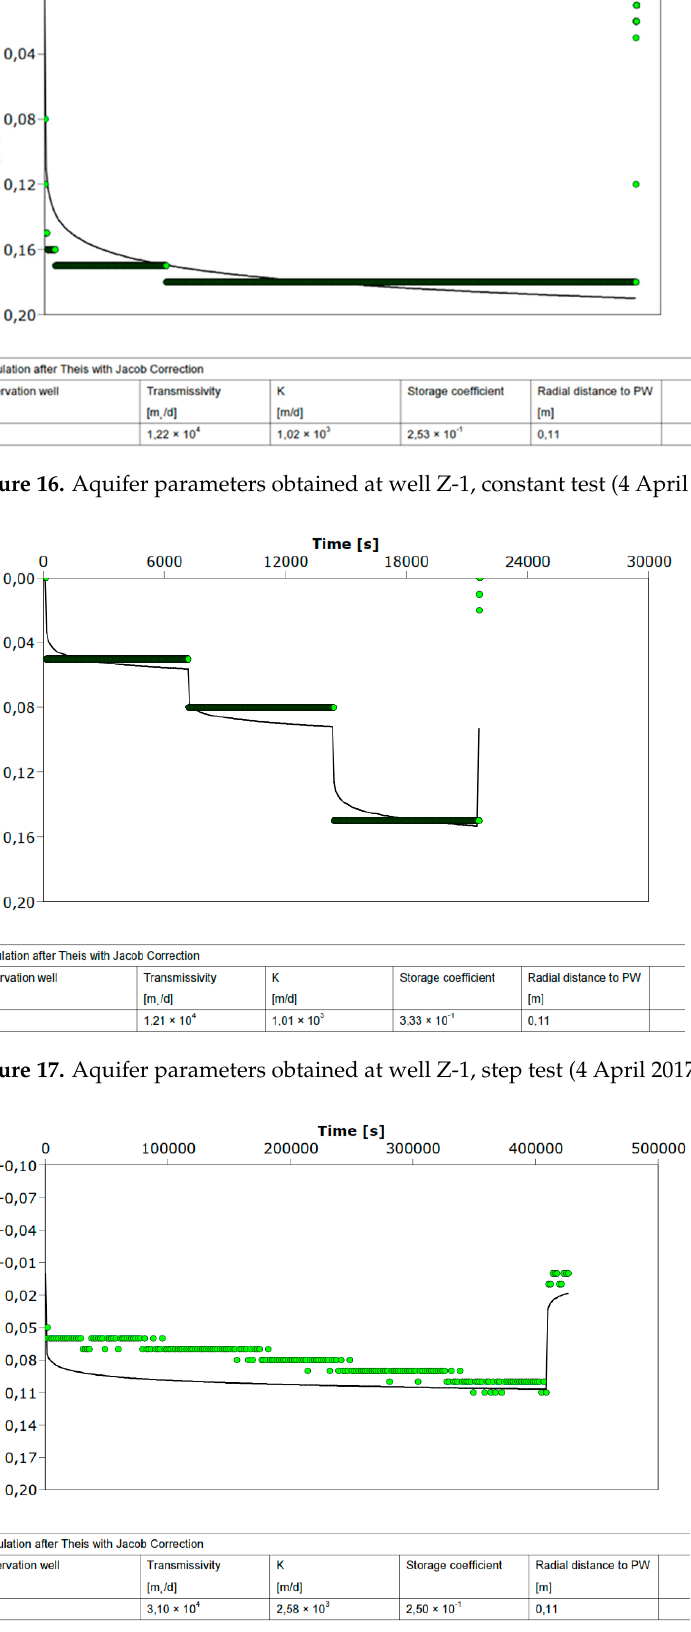
Figure 18. Aquifer parameters obtained at well Z-1, constant test (23 July 2021).